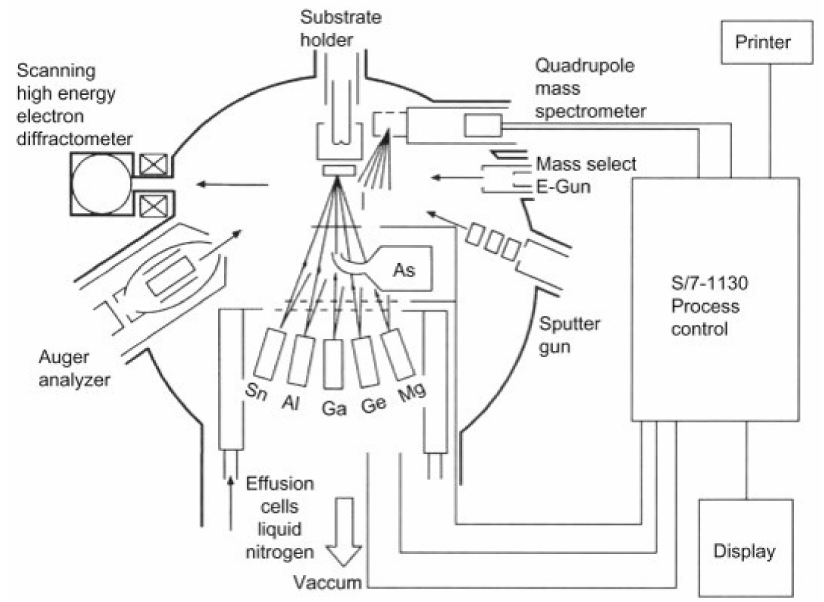
Figure 9. Schematic of MBE system. Reproduced with permission from [91]. Elsevier,